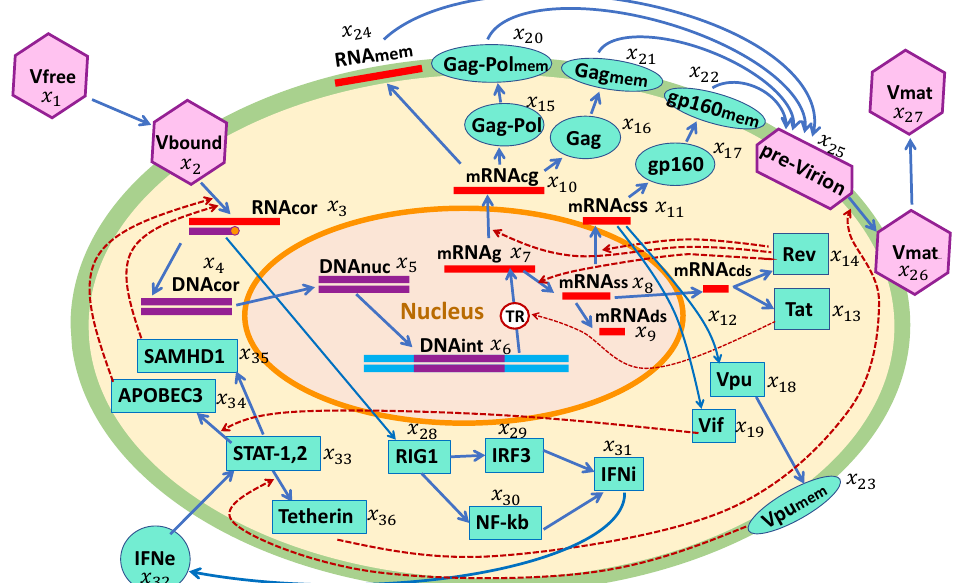
Figure 1. Biochemical scheme of the HIV-1 replication cycle in the presence of an IFN-I response. The consecutive chain of elementary processes comprises: viral entry, reverse transcription, integration into the chromosome, transcription and splicing of viral RNAs, translation of proteins including the proteins inhibiting the action of ISGs, assembly of pre-virions, budding and release of mature virions, sensing of viral RNAs, IFN synthesis, and translation of antiviral proteins by IFN-stimulated